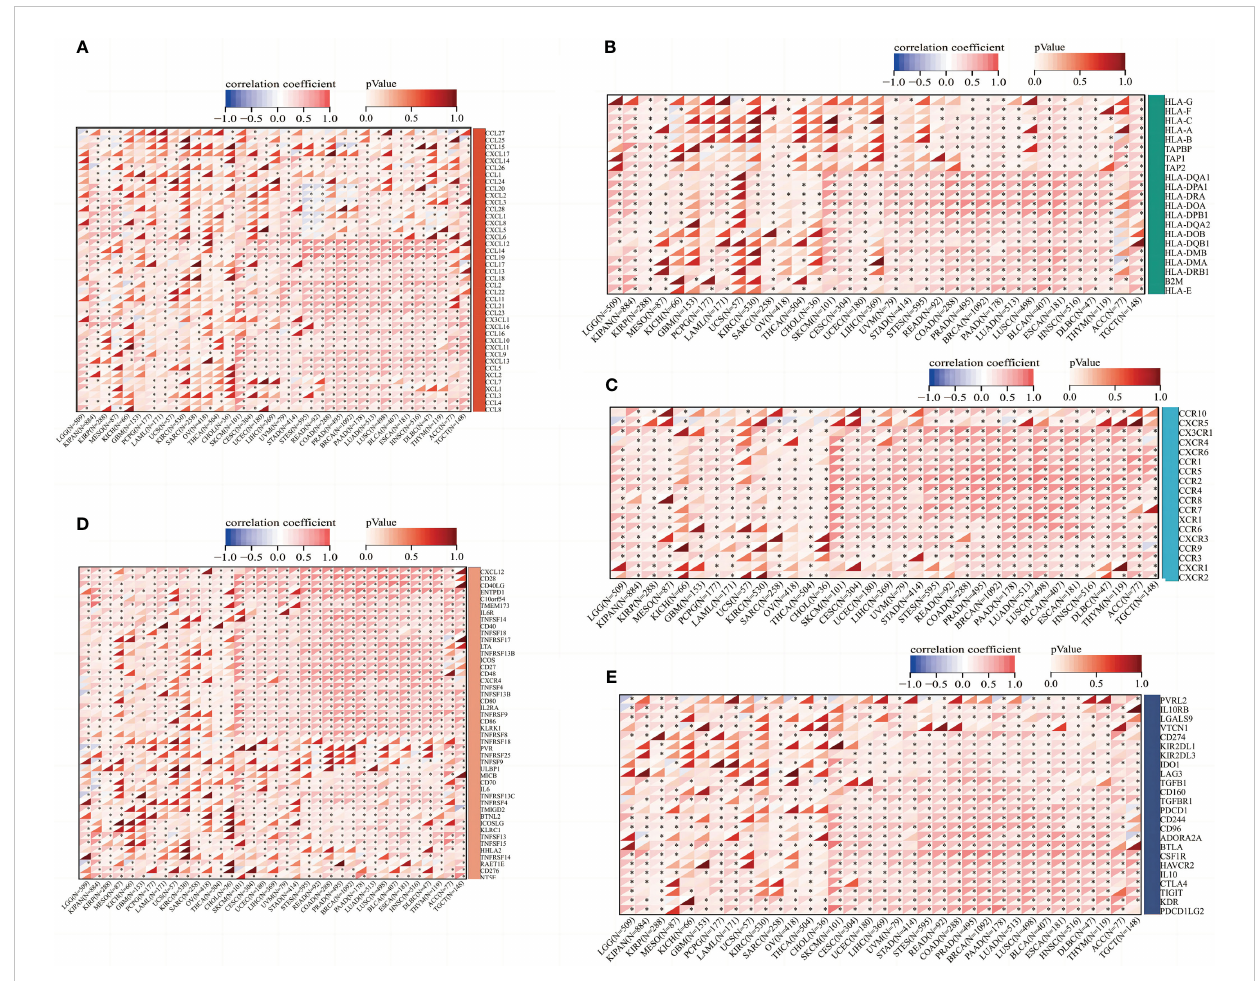
FIGURE 8 Correlation between ABI3BP expression and immune-related genes. (A) Correlation between the expression of ABI3BP and chemokine genes. (B) Correlation between ABI3BP expression and MHC genes. (C) Correlation between ABI3BP expression and receptor genes. (D, E) Correlation of ABI3BP expression with immunosuppressive agents and immunostimulants. *, p <